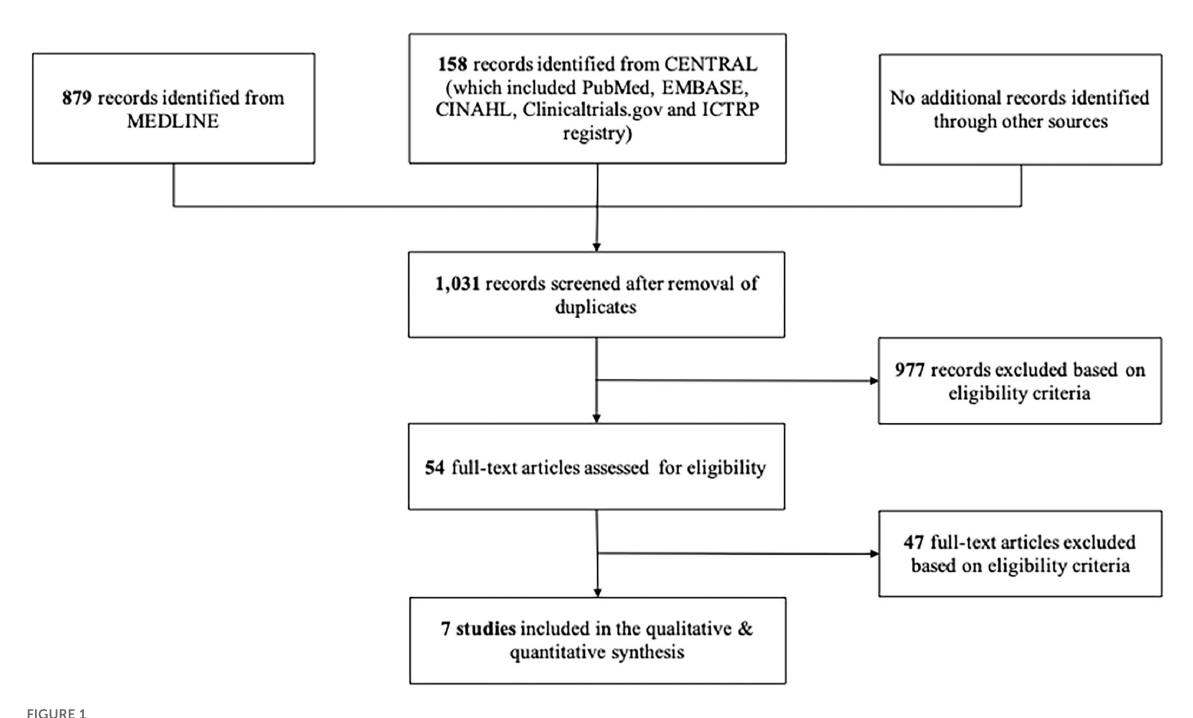
FIGURE1 PRISMA flow